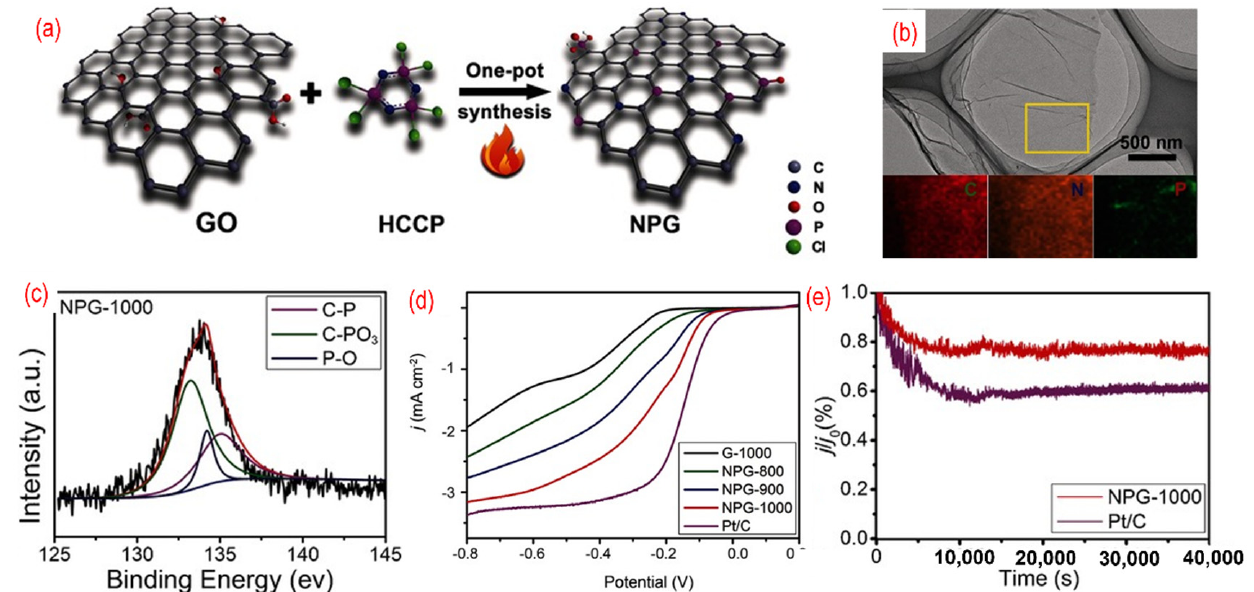
Figure 6. ( a ) The schematic of the synthesis process, ( b ) the TEM image (the inset is C-, N-, and P-elemental mappings), ( c ) the high-resolution P 2p peaks, ( d ) the activity test (LSV curves recorded by RDE in O 2 -saturated 0.1 M KOH solution with 1600 rpm at a scanning rate of 10 mV s − 1 ), ( e ) the stability test (current-time chronoamperometric in O 2 -saturated 0.1 M KOH solution) of P, N-graphene. Reproduced with permission from [81]. © 2022 WILEY-VCH Verlag GmbH & Co. KGaA, Weinheim.